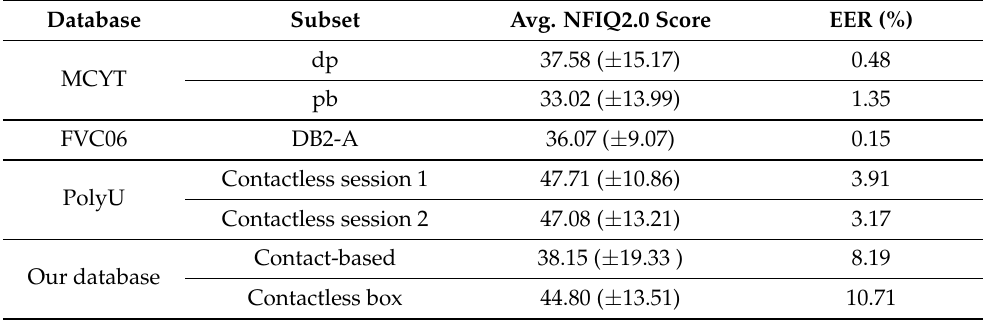
Table 8. Average NFIQ2.0 scores and biometric performance obtained from contactless and contact- based databases including the fingerprint subcorpus of the MCYT Database [38], the FVC2006 Database [39] and the Hong Kong Polytechnic University Contactless 2D to Contact-based 2D Fingerprint Images Database Version 1.0